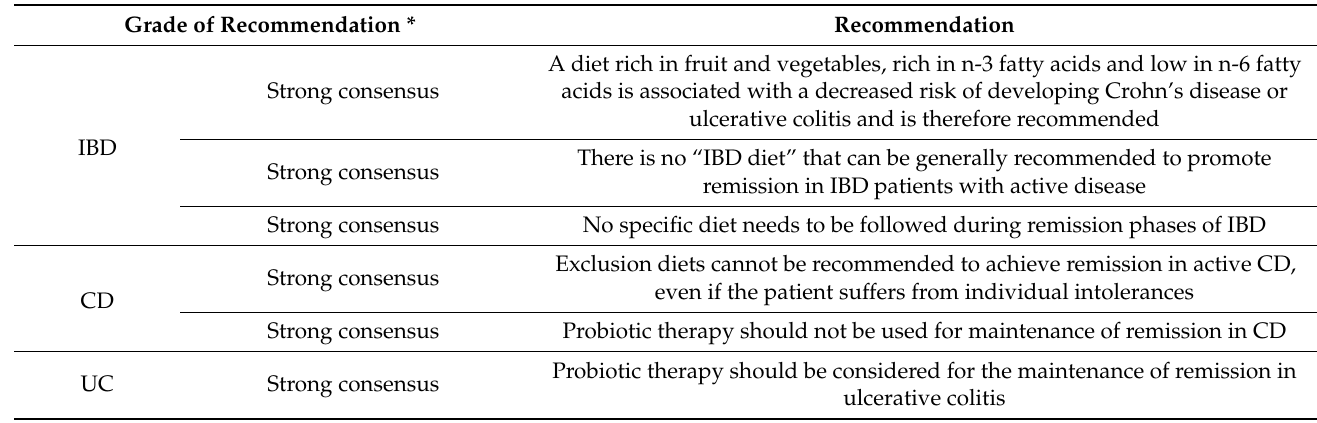
Table 5. European Society for Clinical and Nutritional Metabolism (ESPEN) nutritional recommenda- tions for IBD patients